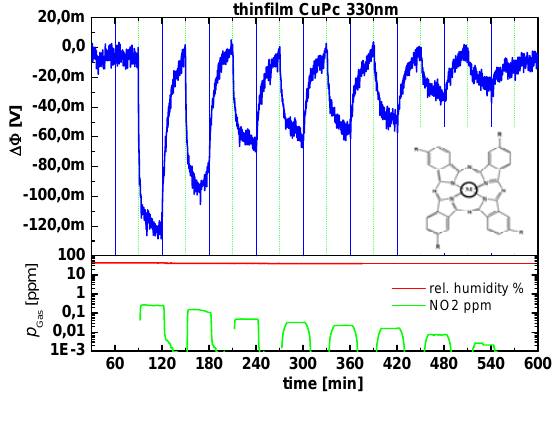
Figure 23. NO 2 -Sensing behavior of GasFETs with Cu-Phtalocyanine thin films: (a) Transient response of the work-function. (b) Sensing characteristics.